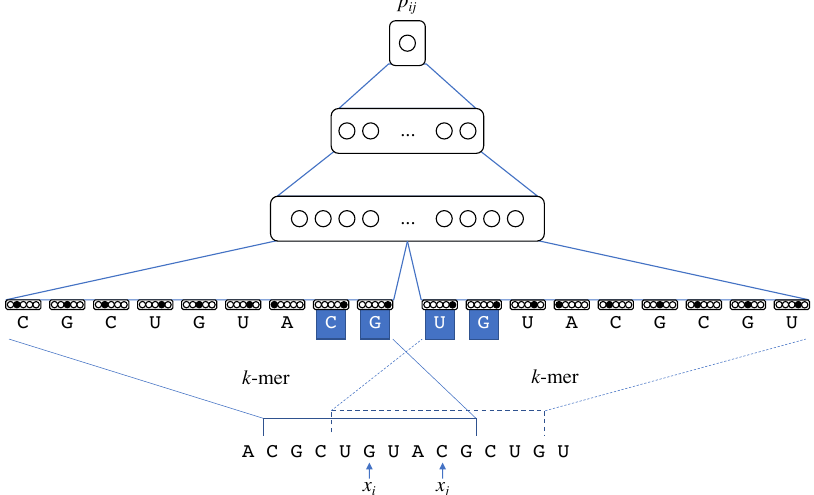
Figure 3. A feedforward neural network with k (= 9 ) -mer contexts around x i and x j used to calculate the base-pairing probability p ij . The end-of-loop nodes of the highlighted nucleotides are activated because they are beyond the paired